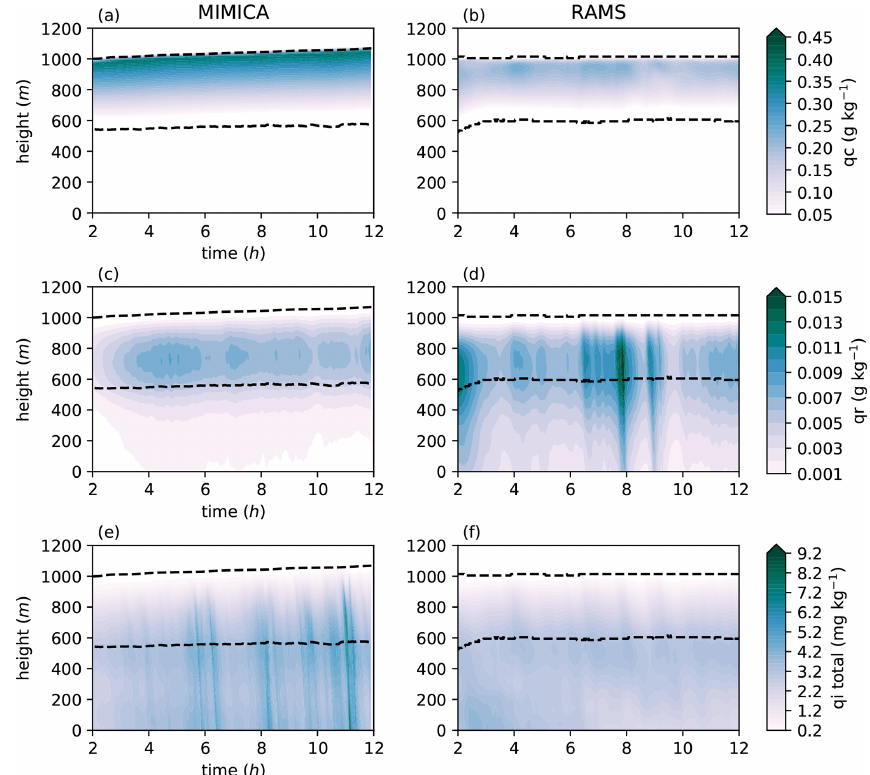
Figure 3. Cloud properties simulated by MIMICA and RAMS for the baseline simulation, i.e. with accumulation and Aitken mode concen- trations of 20cm − 3 . (a, b) Cloud droplet mixing ratio (qc), (c, d) rain mixing ratio (qr) and (e, f) total ice (ice crystals and graupel – and hail for RAMS) mixing ratio (qi total). The first 2h of simulations, considered as the spin-up period, are excluded. Black dashed lines represent the cloud top and cloud base